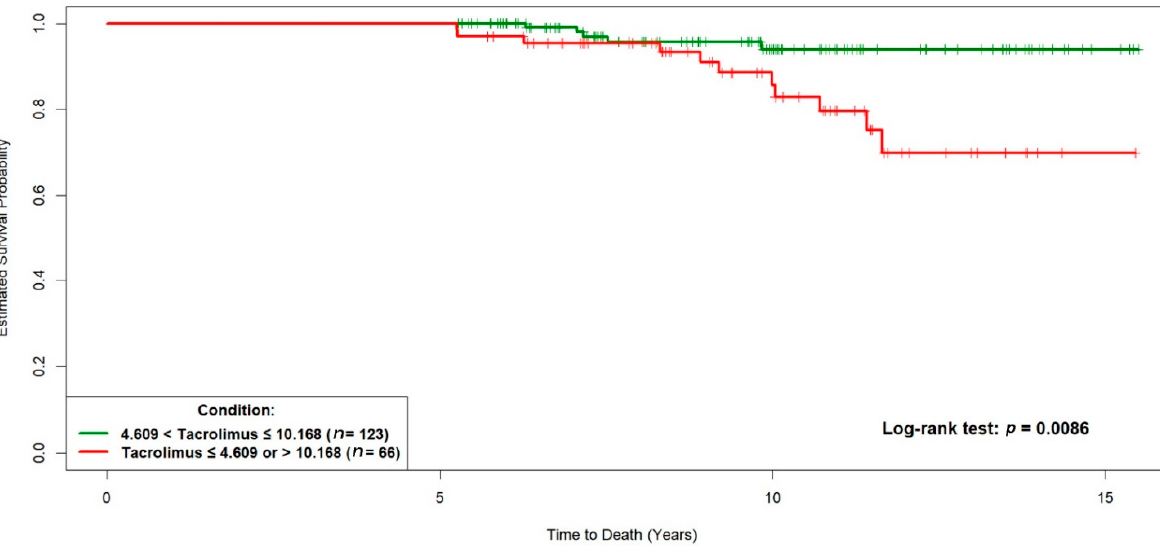
Figure 4. The Kaplan-Meier curve for time to death five years after liver transplantation. The survival curve of the 66 patients with a mean tacrolimus blood trough level ≤ 4.609 ng/mL or >10.168 ng/mL is shown in red while the survival curve of the 123 patients with a mean tacrolimus blood trough level > 4.609 ng/mL or ≤ 10.168 ng/mL is shown in